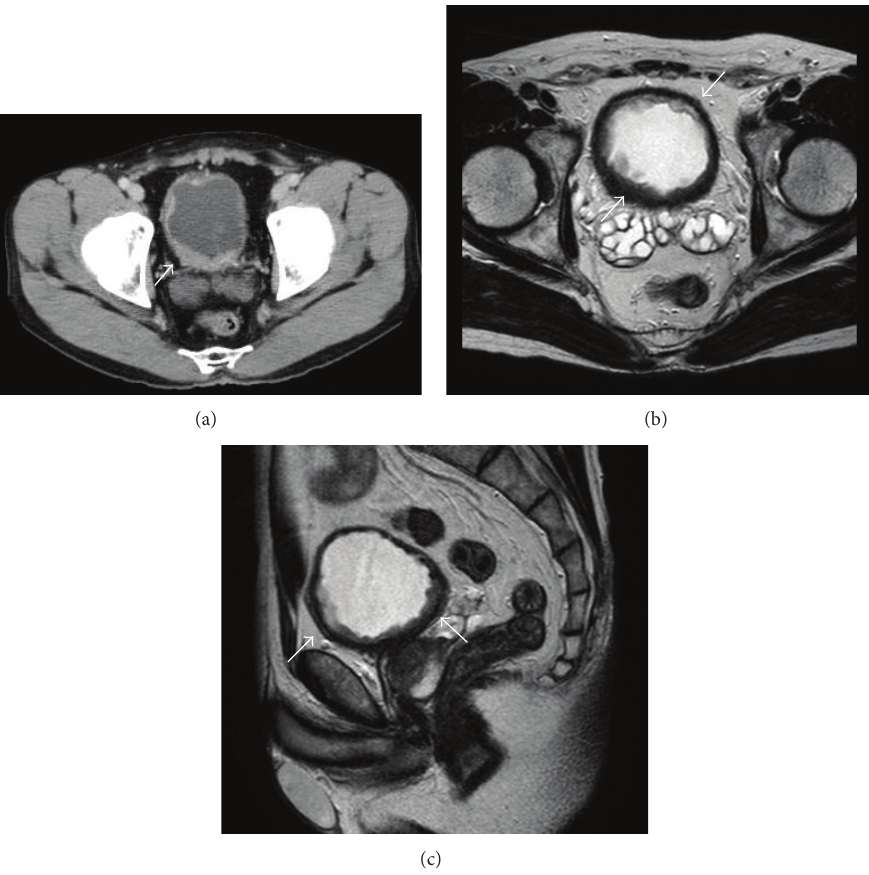
Figure 1: (a) CT shows diffuse tumor of the urinary bladder wall. (b) Transverse section of MRI demonstrates near-circumferential urinary bladder wall thickening. (c) Sagittal section of MRI shows urinary bladder wall thickening from anterior to posterior